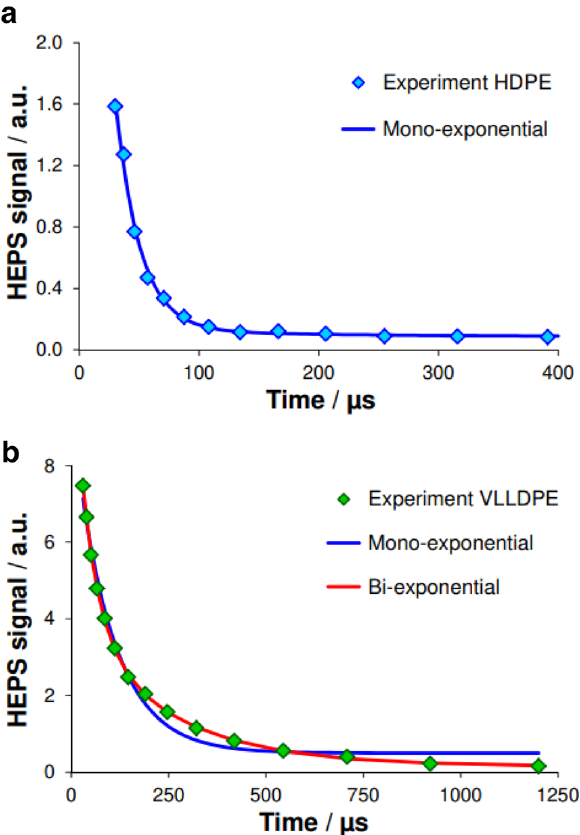
Fig. 12 Mono- and bi-exponential fitting of HEPS data: samples HDPE E ( a ) and VLLDPE A ( b ) Spintrack